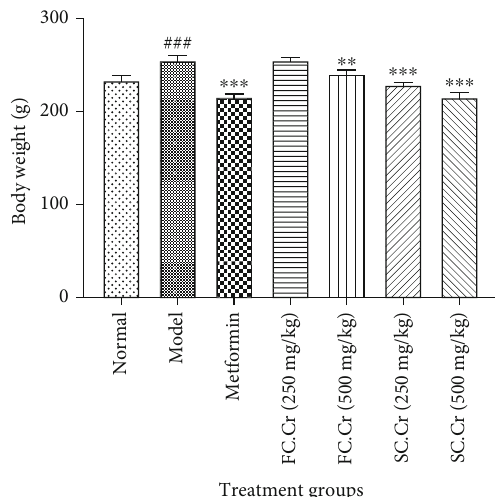
Figure 1: Graphical representation of fasting blood glucose level (mg/dL) after intervention with FC.Cr. and SC.Cr. in HFD-STZ- induced rats. The fasting blood glucose level of FC.Cr. and SC.Cr. at doses 250mg/kg and 500 mg/kg is compared with the standard drug metformin at the end of the study duration. The values are expressed as the mean of six animals in a group. Statistical analysis is performed with one-way ANOVA followed by Tukey ’ s test. All the groups are compared with the HFD-STZ group, while the HFD-STZ group is compared with the normal group. The results are considered signi fi cant ( ∗ ) if P < 0 : 05 and ( ∗∗ ) if P < 0 : 01 and highly signi fi cant ( ∗∗∗ ) if P < 0 : 001